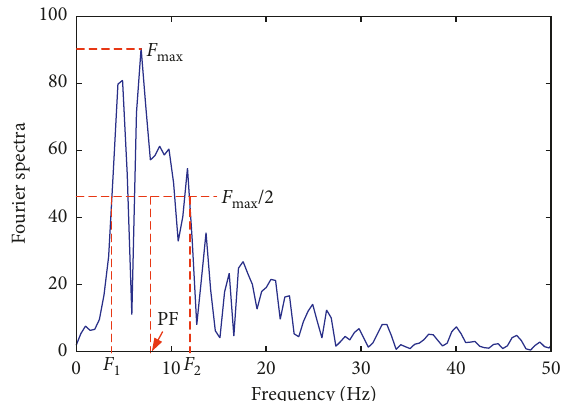
Figure 7: Definitions of principal frequency (PF).